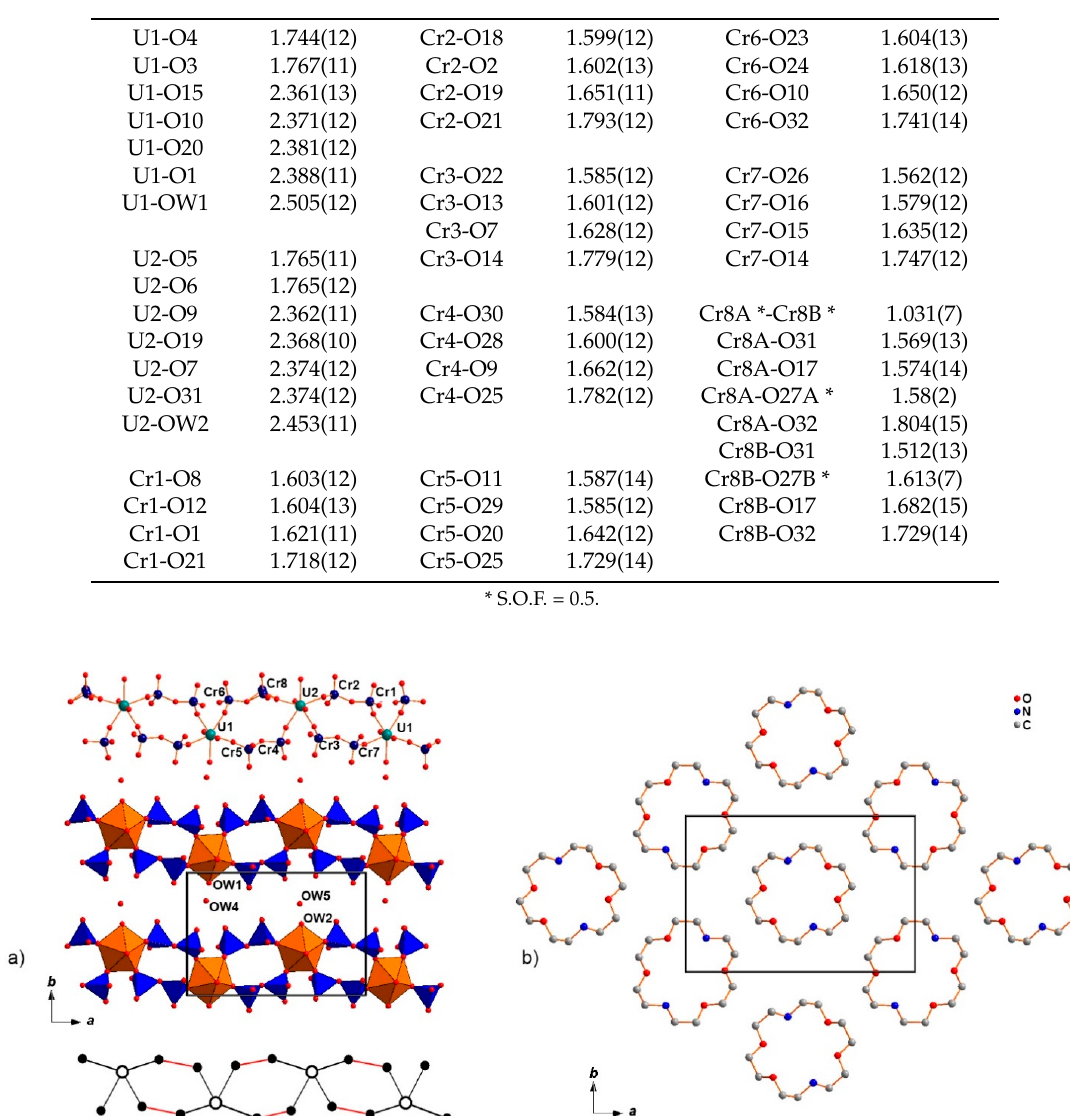
Table 2. Selected interatomic distances (Å) in 1 .